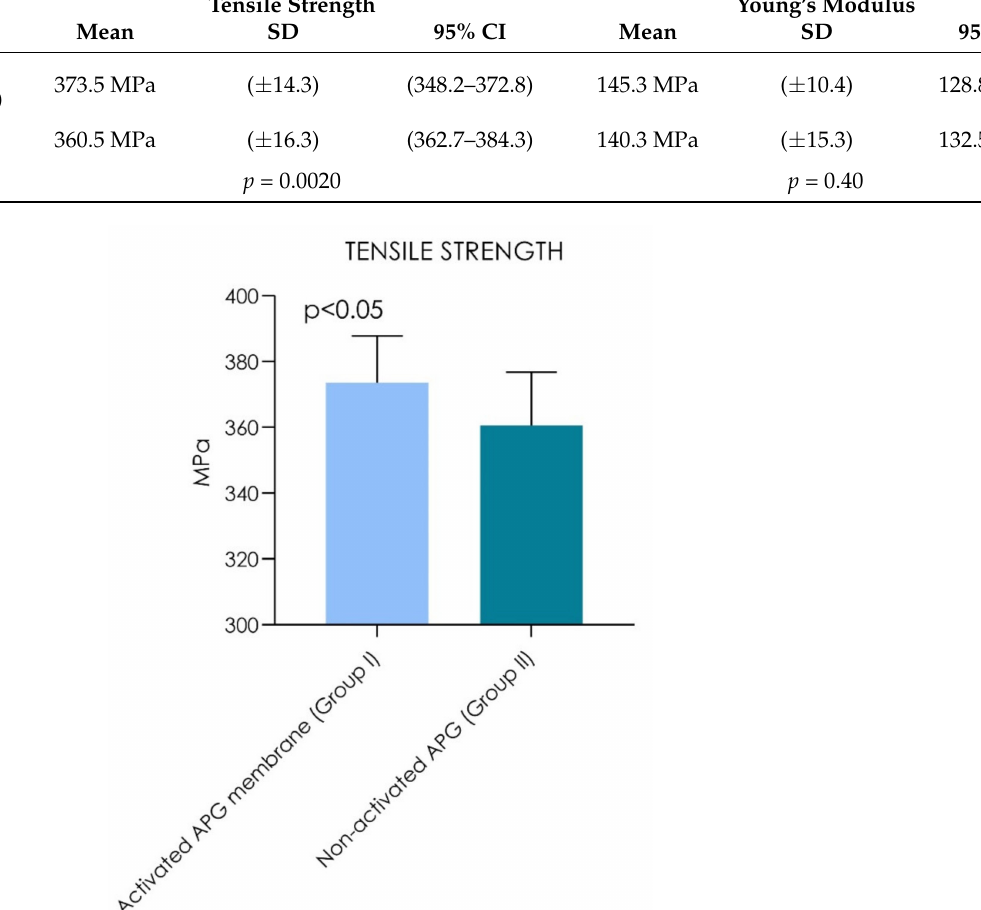
Table 1. Summary of the tensile strength (MPa) and Young’s modulus (Wilcoxon signed-rank test). Tensile Strength Young’s Modulus